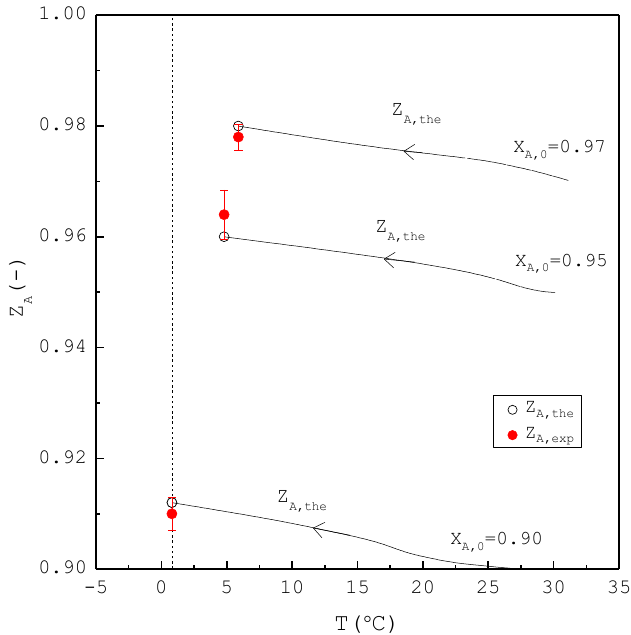
Figure 12. Comparison between Z A , exp and Z A , the of the final product for the purification of m - chlorophenol for each X A ,0 , where Z A , the ( T ) is plotted against the operating temperature for each X A ,0 . Each solid circle data point represents the average Z A , exp for four repetitive experiments and error bar represents the 95% confidence interval for the experimental Z A , exp .